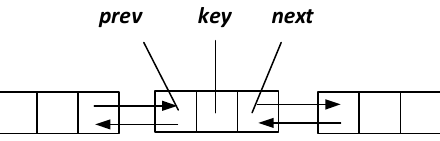
Figure 5. The structure of an element of a doubly linked list